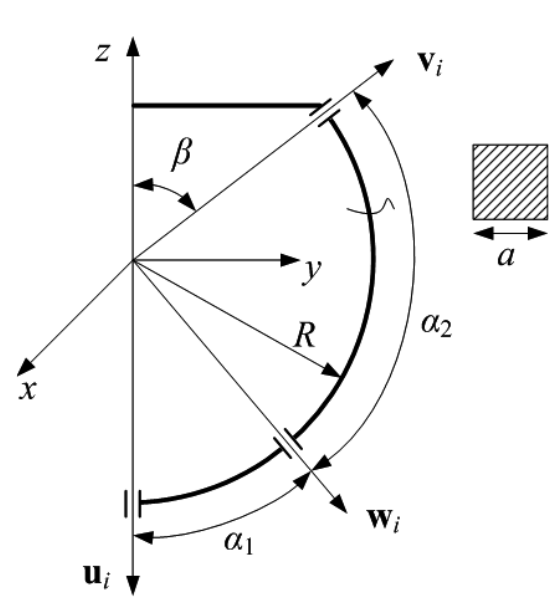
Figure 5: Design variables of the 3-RRR